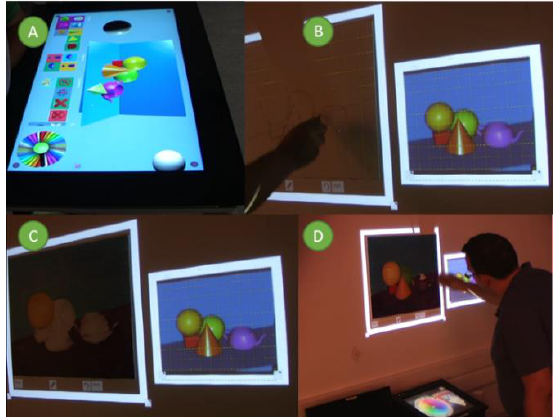
Figure 7. Intermediate steps for the creation a painting exercise using 3D